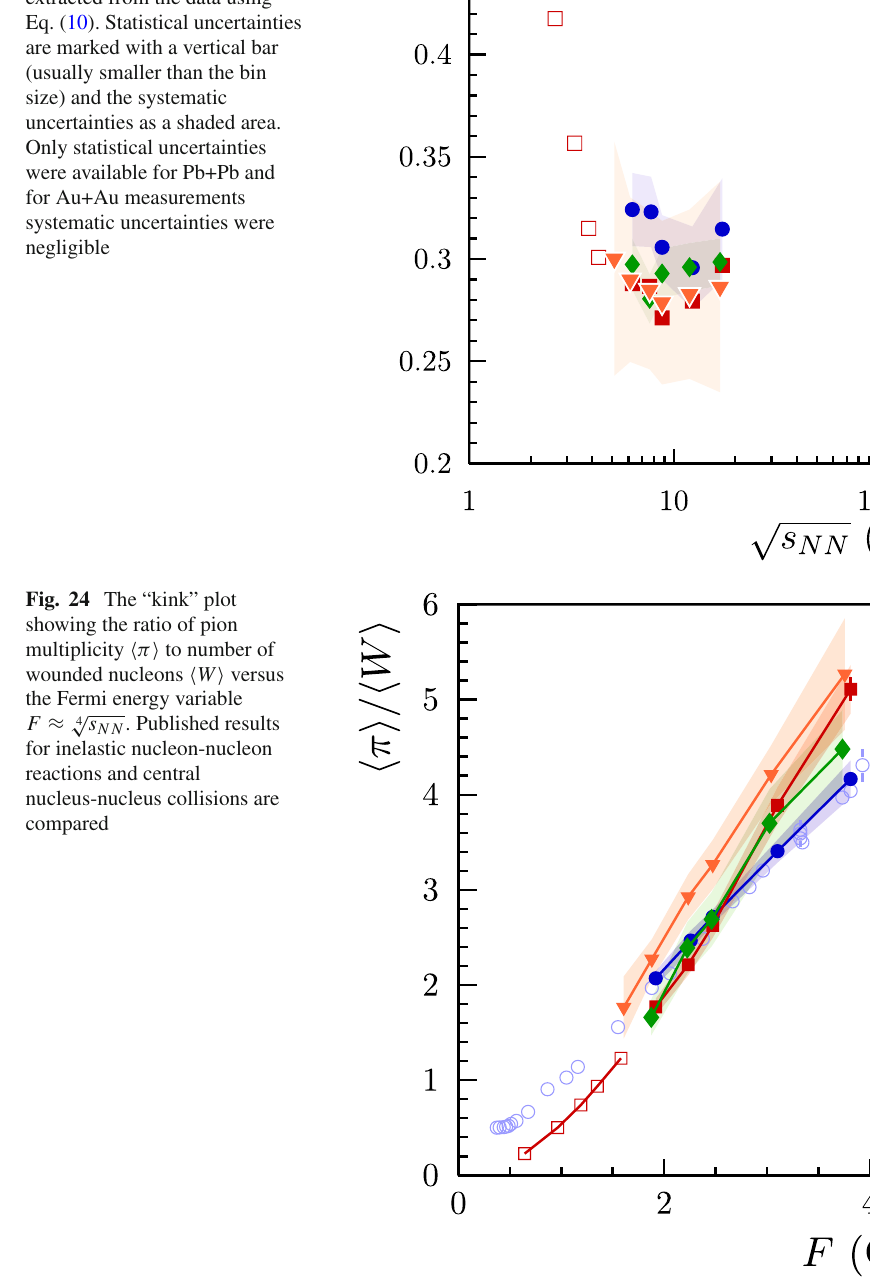
Fig. 23 The speed of sound as a function of beam energy as extracted from the data using Eq. (10). Statistical uncertainties are marked with a vertical bar (usually smaller than the bin size) and the systematic uncertainties as a shaded area.